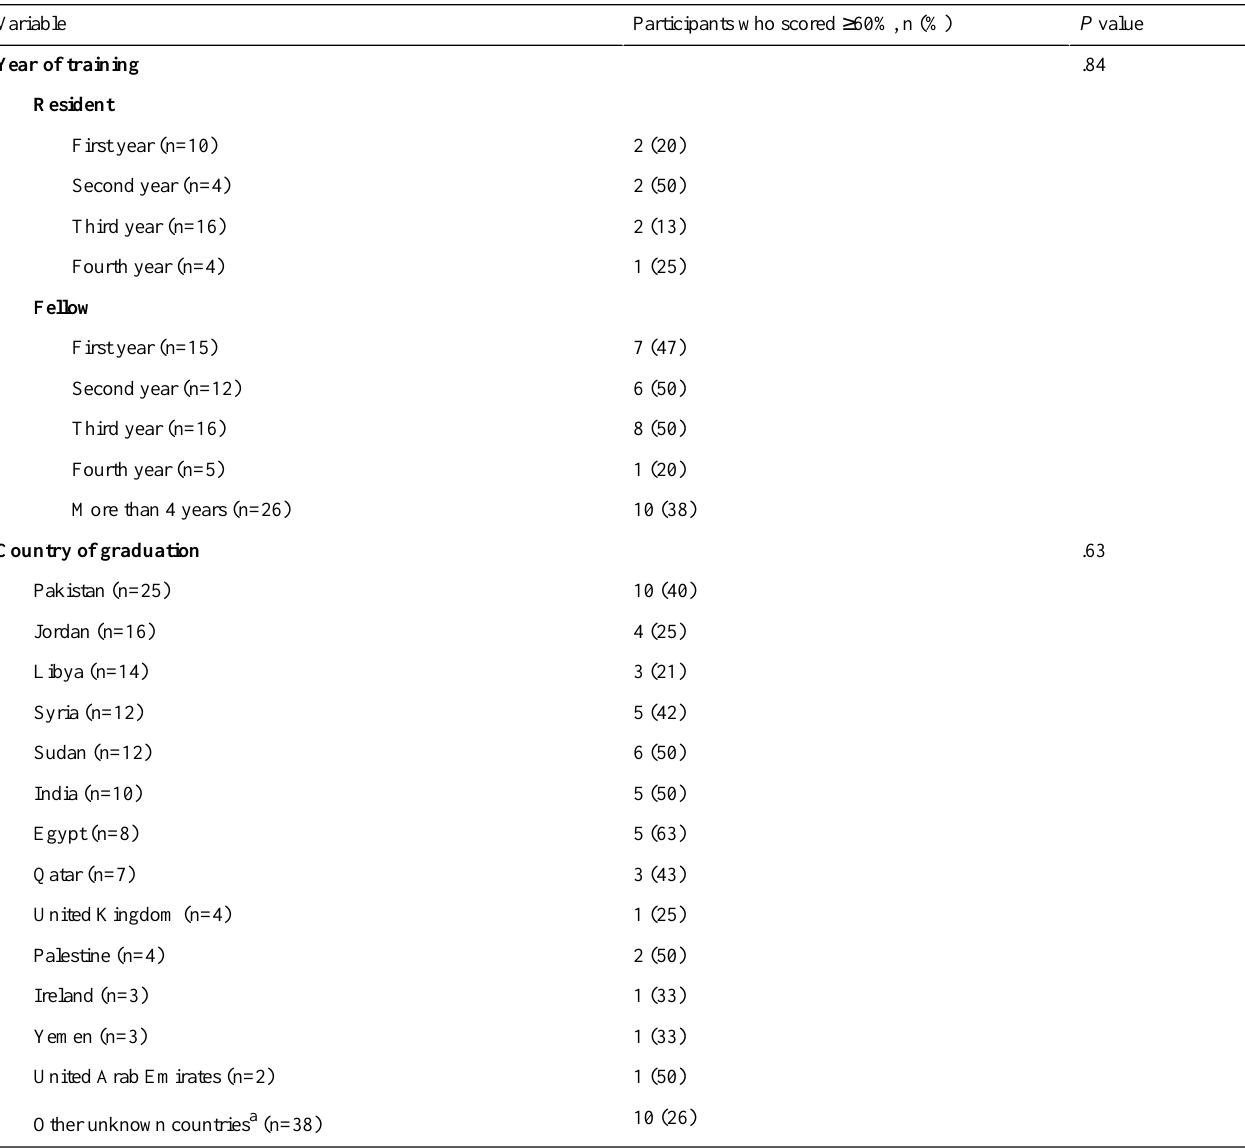
Table 3. Comparison of the years and level of training and country of graduation of participants in the high-score group